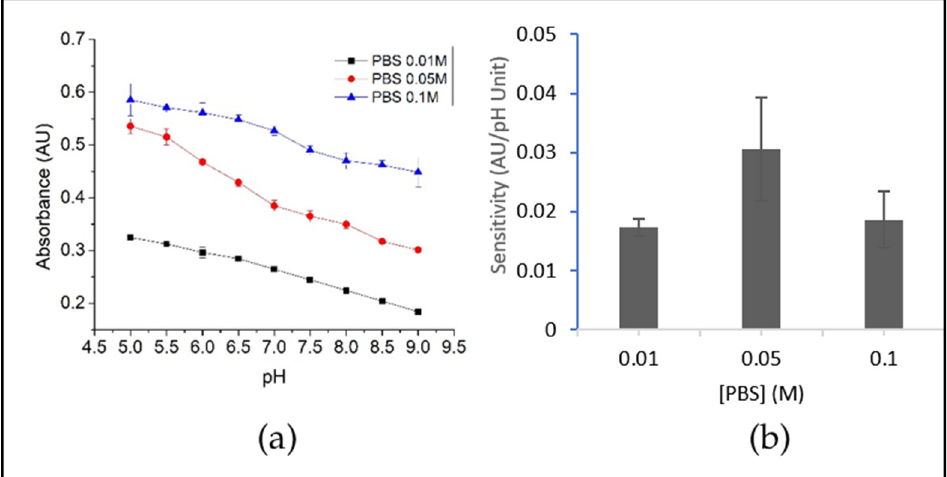
Figure 4. Response profile ( a ) and sensitivity ( b ) values of the manufactured optical pH sensors with various PBS concentrations. The absorbance was measured over a pH range of 4.5 to 9.5.